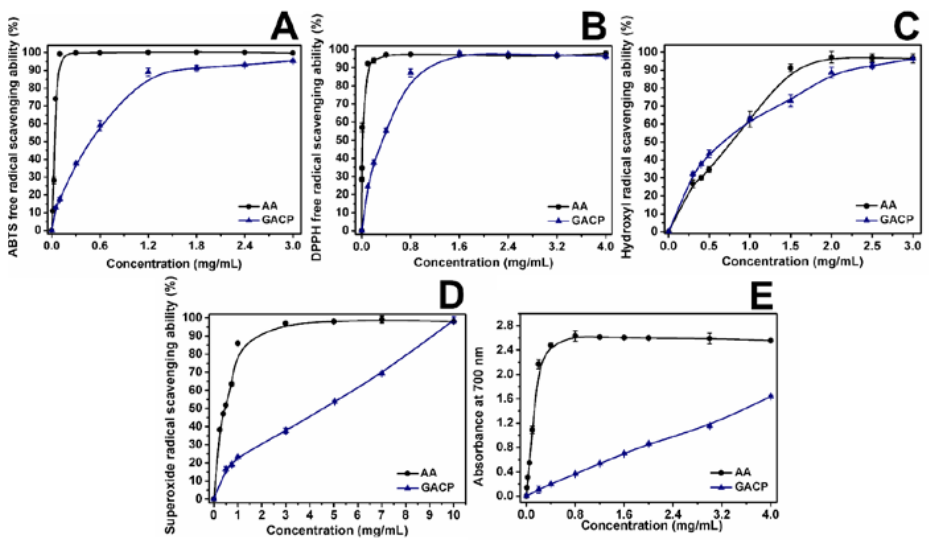
Figure 4. Antiradical activity of AA and GACP: ABTS radical assay ( A ); DPPH radical assay ( B ); hydroxyl radical assay ( C ); superoxide radical assay ( D ); reducing power assay ( E ). AA: ascorbic acid; ABTS: 2,2-azino-bis-(3-ethyl-benzthia-6-sulfonic acid); DPPH: 1,1-diphenyl-2-picrylhydrazyl. The ability to scavenge the DPPH radical of GACP was lower compared with AA at concentrations between 0.1–0.8 mg/mL. The DPPH radical scavenging rate of AA was 97.16% and was close to that of GACP (97.09%) when the concentration reached 1.6 mg/mL (see Figure 4B). Comparing the IC 50 value of Ganoderma lucidum (0.41 mg/mL) [27], and Pleu- rotus ostreatus (2.14 mg/mL) [53] polysaccharides, the IC 50 value of GACP (0.36 ± 0.01